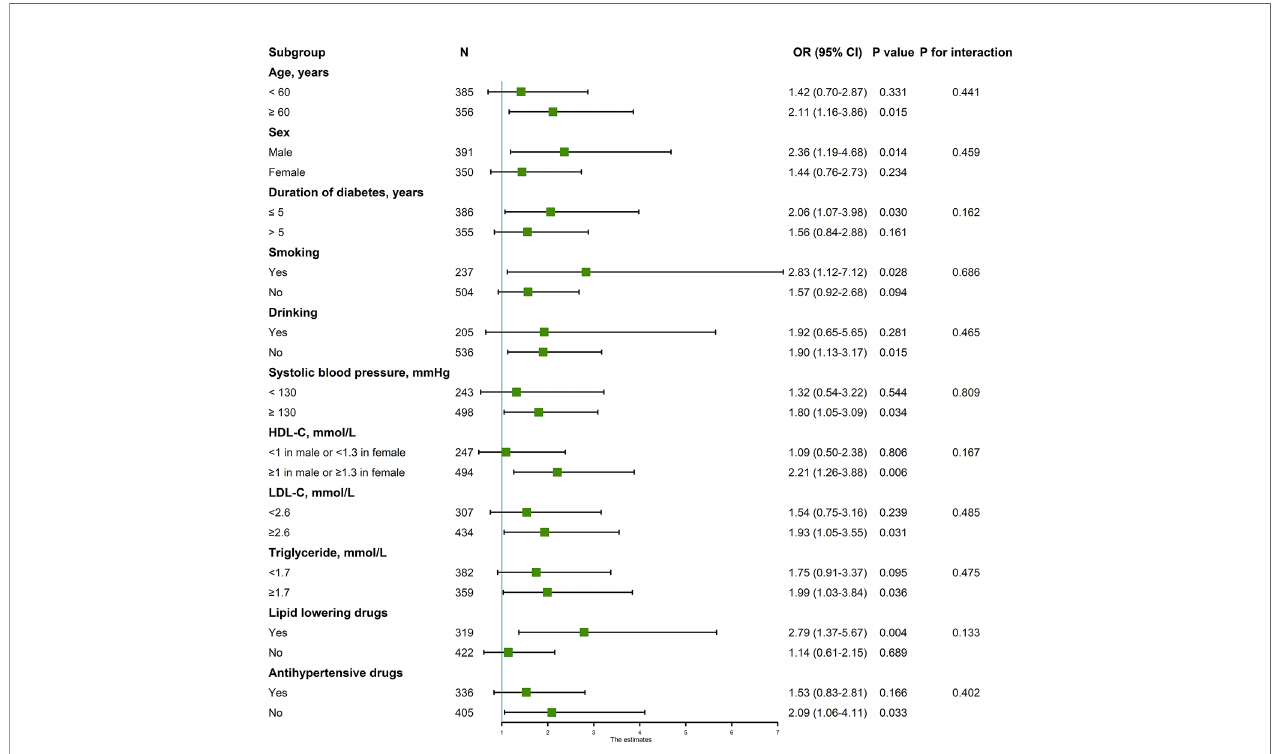
FIGURE 1 | Associations between factor3 (top tertile vs. bottom tertile) and CVD in subgroups. Adjusted for age, sex, duration of diabetes, current smoking, current drinking, body mass index ( ≤ 18.5 kg/m 2 , 18.5 – 24 kg/m 2 , 24 – 28 kg/m 2 , ≥ 28 kg/m 2 ), systolic blood pressure, high-density lipoprotein cholesterol (<1 mmol/L in male or <1.3 mmol/L in female, ≥ 1 mmol/L in male or ≥ 1.3 mmol/L in female), low-density lipoprotein cholesterol (<2.6 mmol/L, ≥ 2.6 mmol/L), glycated hemoglobin (<7%, 7%~8%, ≥ 8%, lack), triglyceride (<1.7 mmol/L, ≥ 1.7 mmol/L), antidiabetic drugs, lipid lowering drugs, and antihypertensive drugs. CVD, cardiovascular diseases; OR, odds ratio; CI, con fi dence interval; BMI, body mass index; SBP, systolic blood pressure; DBP, diastolic blood pressure; HDL-C, high-density lipoprotein cholesterol; LDL-C, low-density lipoprotein cholesterol; HbA1c, glycated